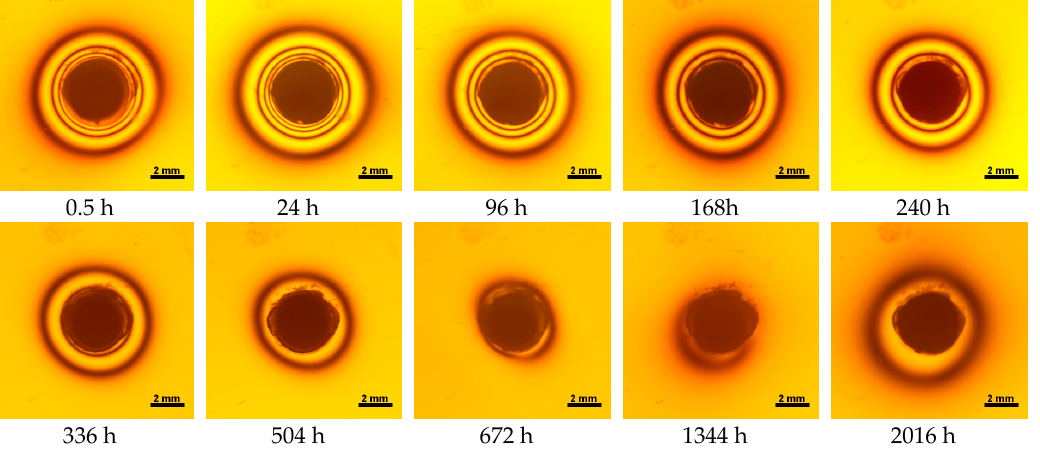
Figure 15. Isochromes in an epoxy plate around Maxcem Elite Chroma restoration before and after water storage; 0.5–2016 h.